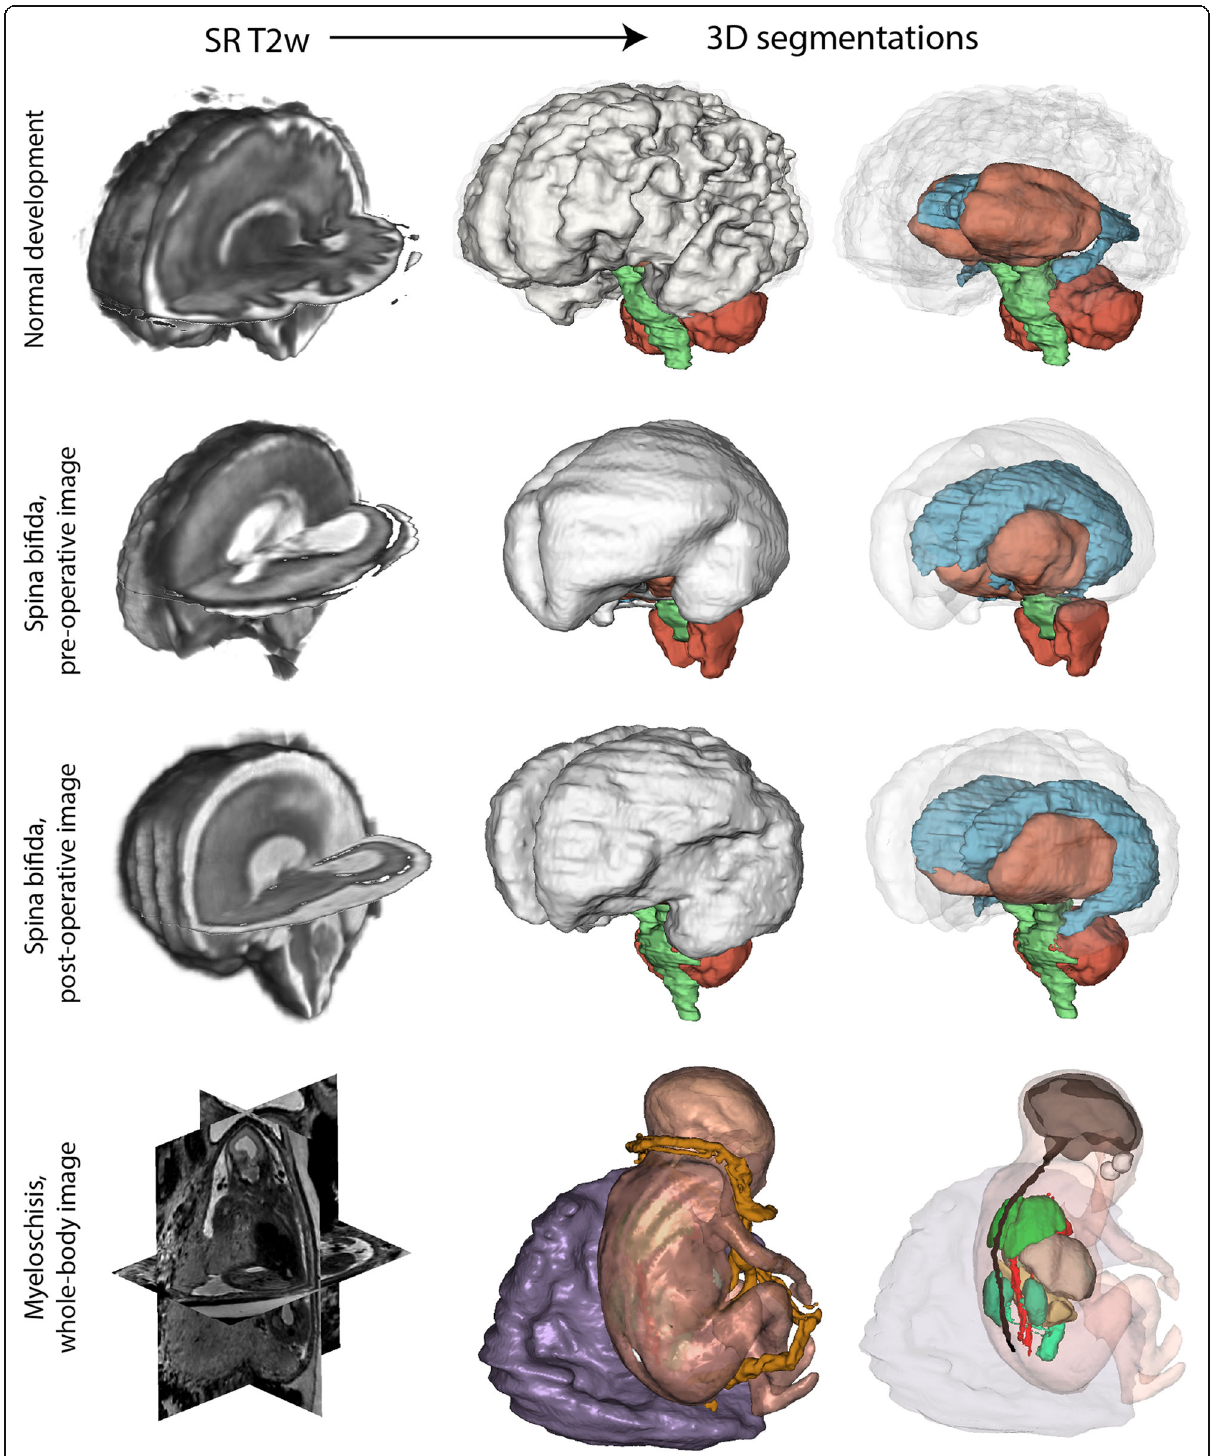
Fig. 1 Super-resolution (SR) reconstruction of foetal MRI. For each case (normal development, pre-operative, and post-operative images of spina bifida foetus undergoing foetal surgery and myeloschisis), we demonstrate the super-resolution T2-weighted MRI (left images) and two surface reconstructions that were based on the segmentation of the reconstructed image (right